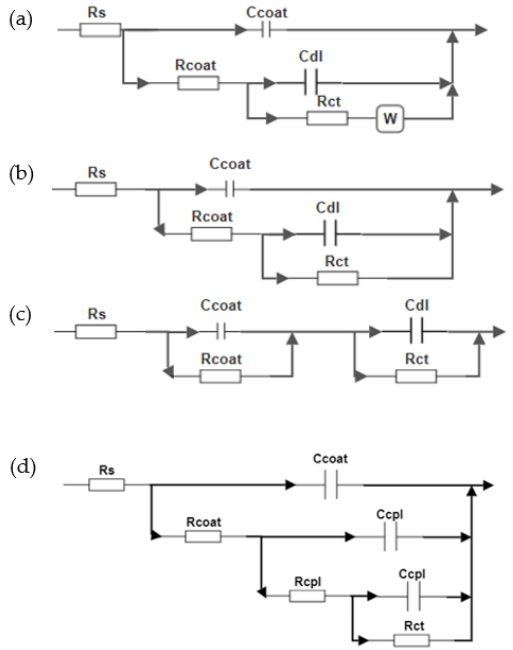
Figure 10. Electrical equivalent circuits for: ( a ) L-tryptophan and Zn sample; ( b ) Inhibitor 2; ( c ) 1; and ( d ) Inhibitor Inhibitor 1; and ( d ) Inhibitor 3.